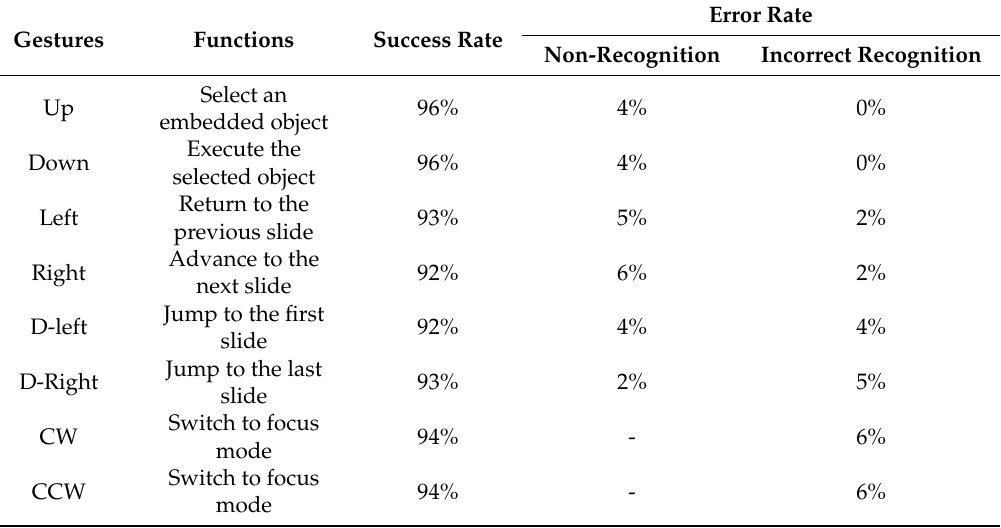
Table 5. Result of the presentation software (participant = 5; trials =